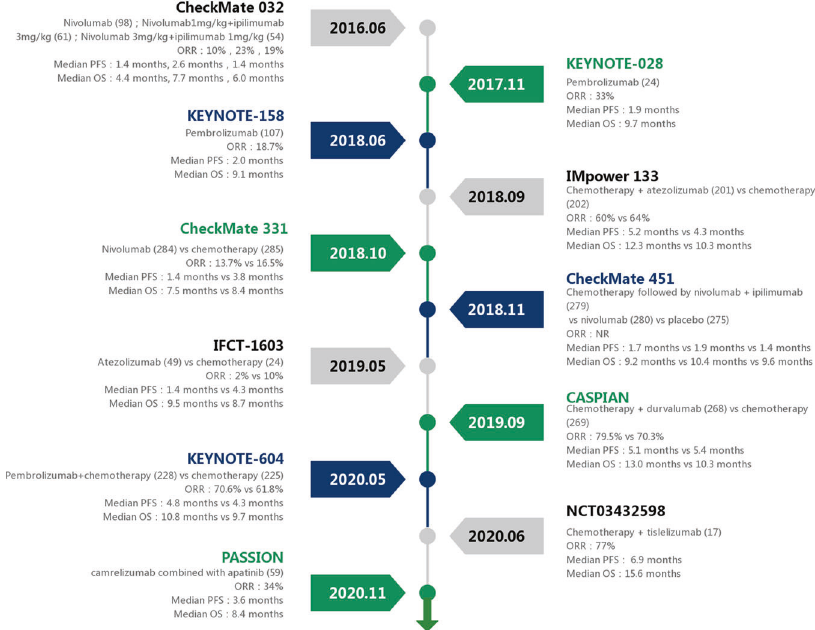
Fig. 2 Timeline of key studies of immune checkpoint inhibitors in SCLC. This timeline describes some key studies using immune checkpoint inhibitors in patients with SCLC. NR not reported, ORR objective response rate, PFS progression-free survival, OS overall